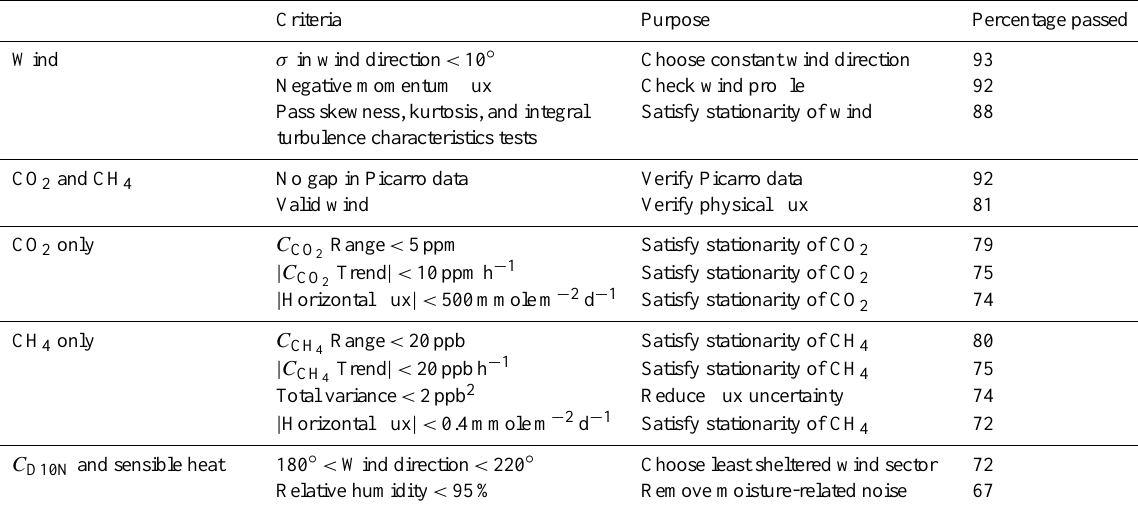
Table A1. Filtering criteria (within 10min averaging intervals) for quality control of eddy covariance fluxes. These criteria are shown for the south-west air sector only (180 ◦ < Wind direction < 240 ◦ ). The right column indicates the percentage of valid flux data that satisfy the filtering criteria by each stage of the quality control sequence. Criteria Purpose Percentage passed